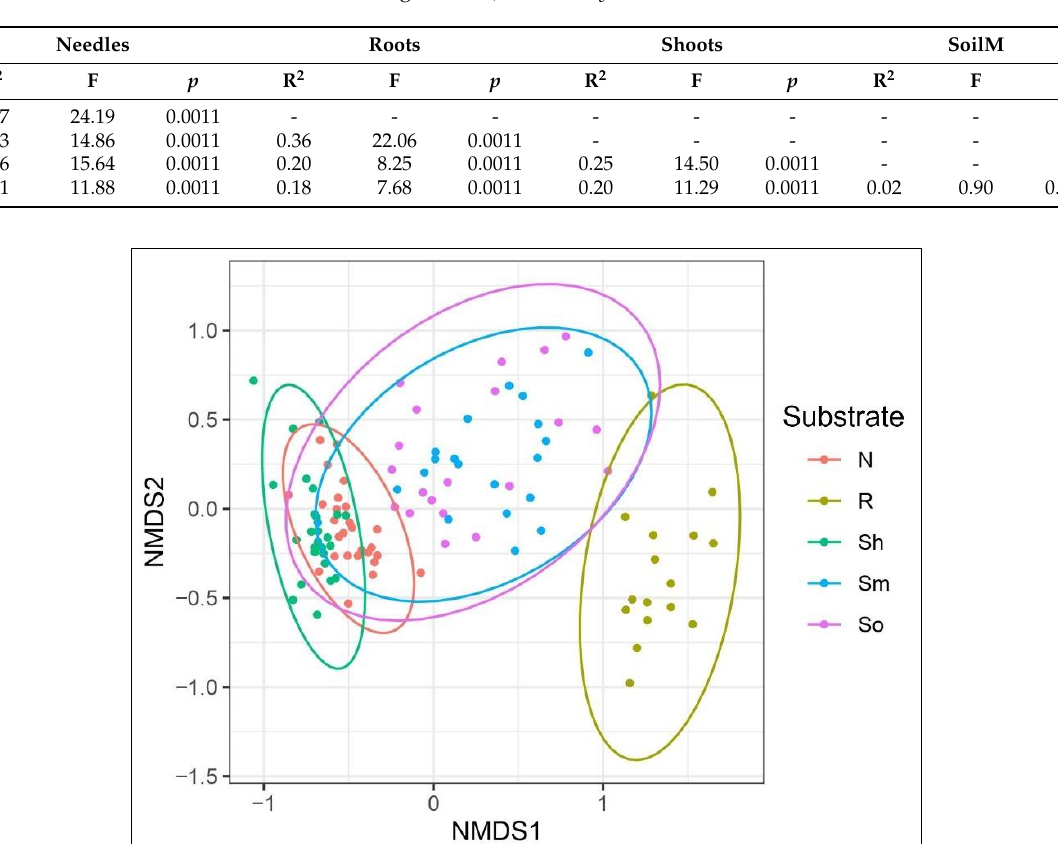
Table 4. Pairwise comparison of the fungal communities among different substrates (needles, roots, shoots, mineral soil, and organic soil) of Pinus sylvestris .